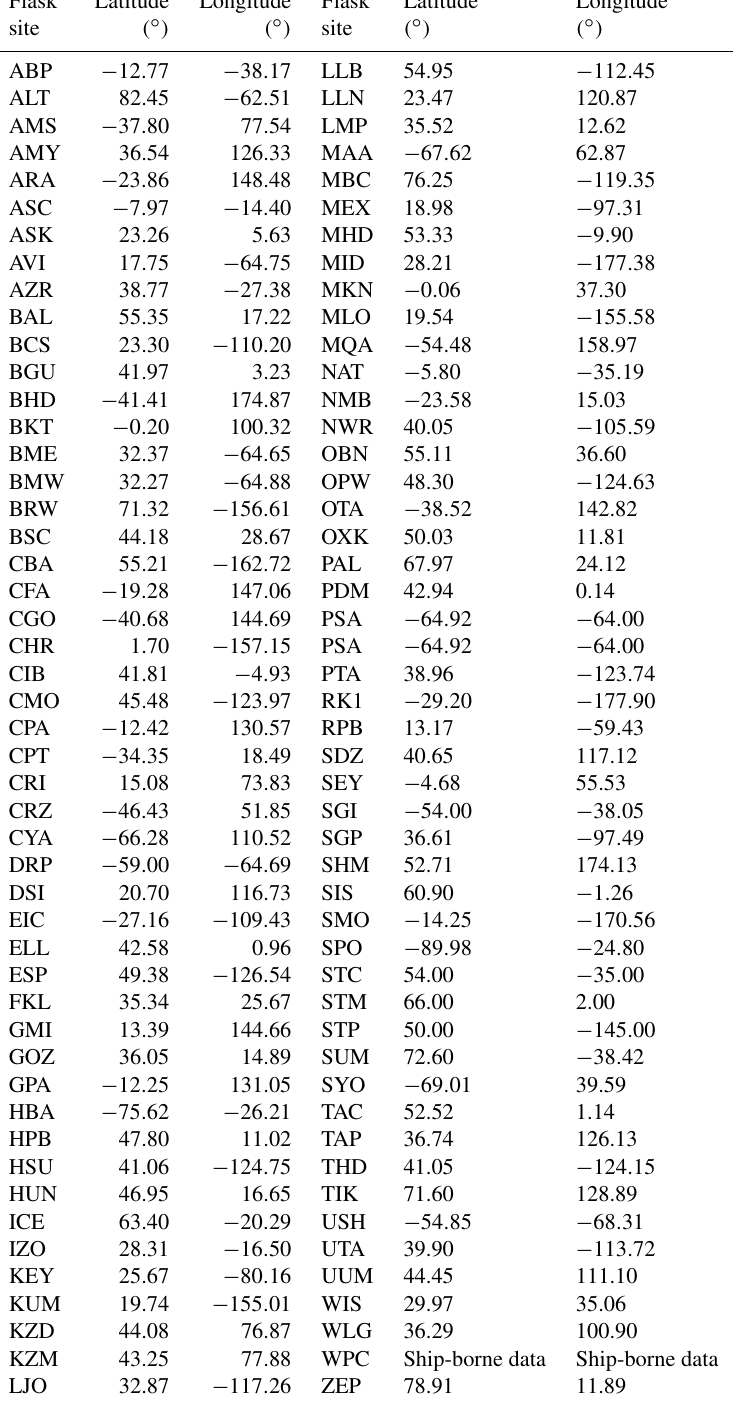
Table 4. NOAA flask sites used in the